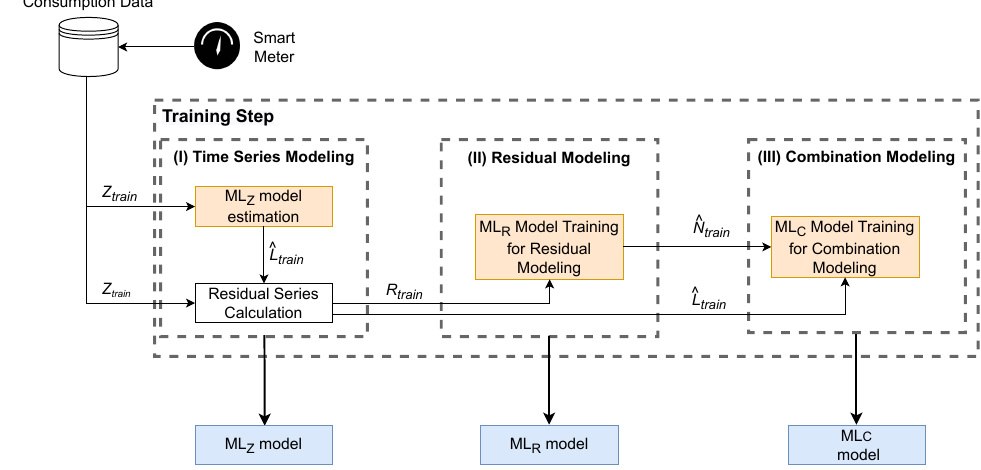
Figure 1. Diagram of the training step of the Evolutionary Hybrid System